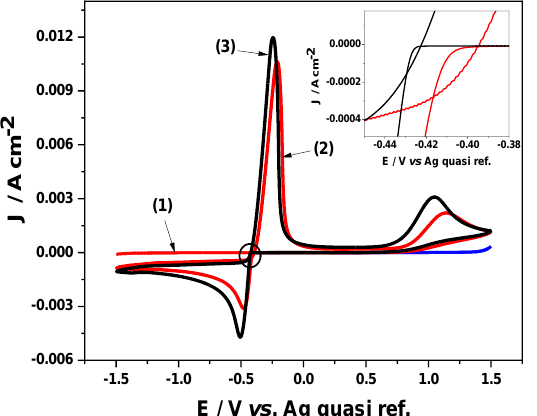
Figure 2. Cyclic voltammograms on GC at scan rate 20 mV s − 1 in blank ILEG (1), ILEG containing 0.05 M SnCl 2 (2) and 0.05 M SnCl 2 and 20 mg L − 1 GO (3), 25 °C. The inset shows the crossover in the encircled area.